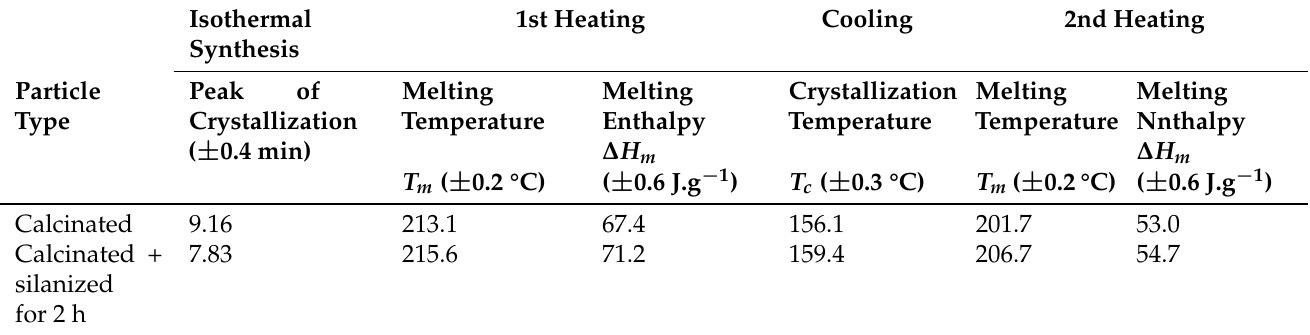
Table 3. Thermal properties of the crystalline phase of PA6-glass particles composites synthesized with calcinated particles and calcinated + 2h-silanized particles: Time at which the crystallization peak is observed during the isothermal step of polymerization and crystallization at 180 ◦ C, and subsequent PA6 melting/crystallization temperatures, and melting enthalpies, associated to the heat-cool-heat experiments after composite synthesis.